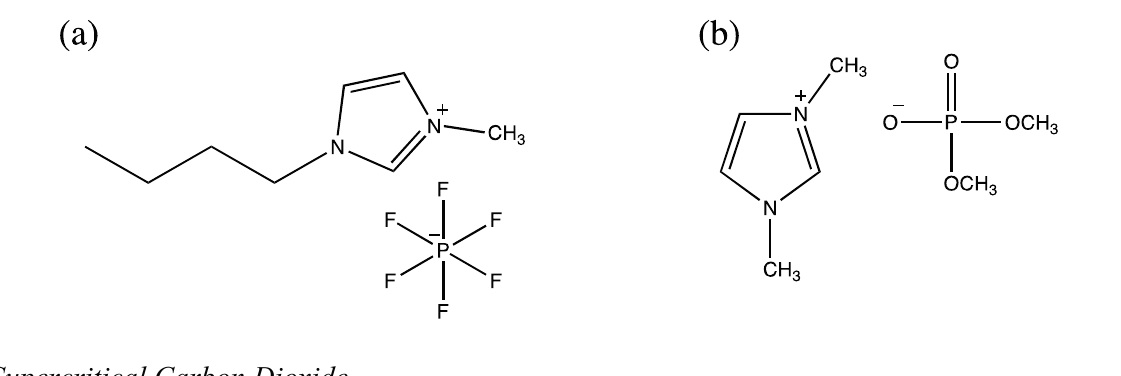
Figure 2. ( a ) 1-Butyl-3-methylimidazolium hexafluorophosphate; ( b ) 1,3-Dimethyl- imidazolium